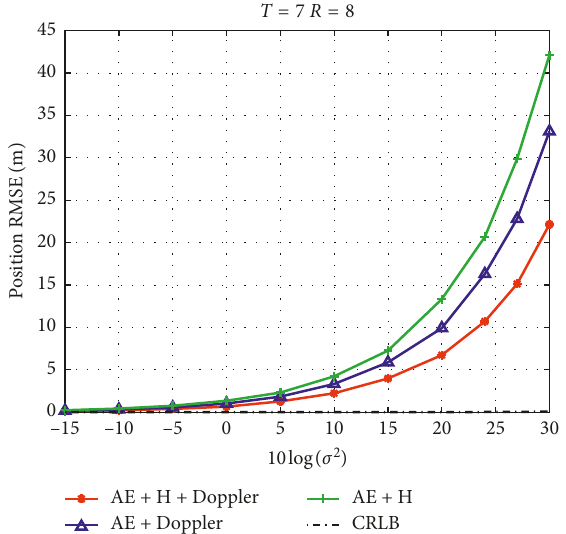
Figure 4: Comparison of the position RMSE of the proposed method with AE +Doppler, AE+H, and CRLB when T � 7, R � 8. The CRLB is close to zero, but it is going up as the noise power increases.